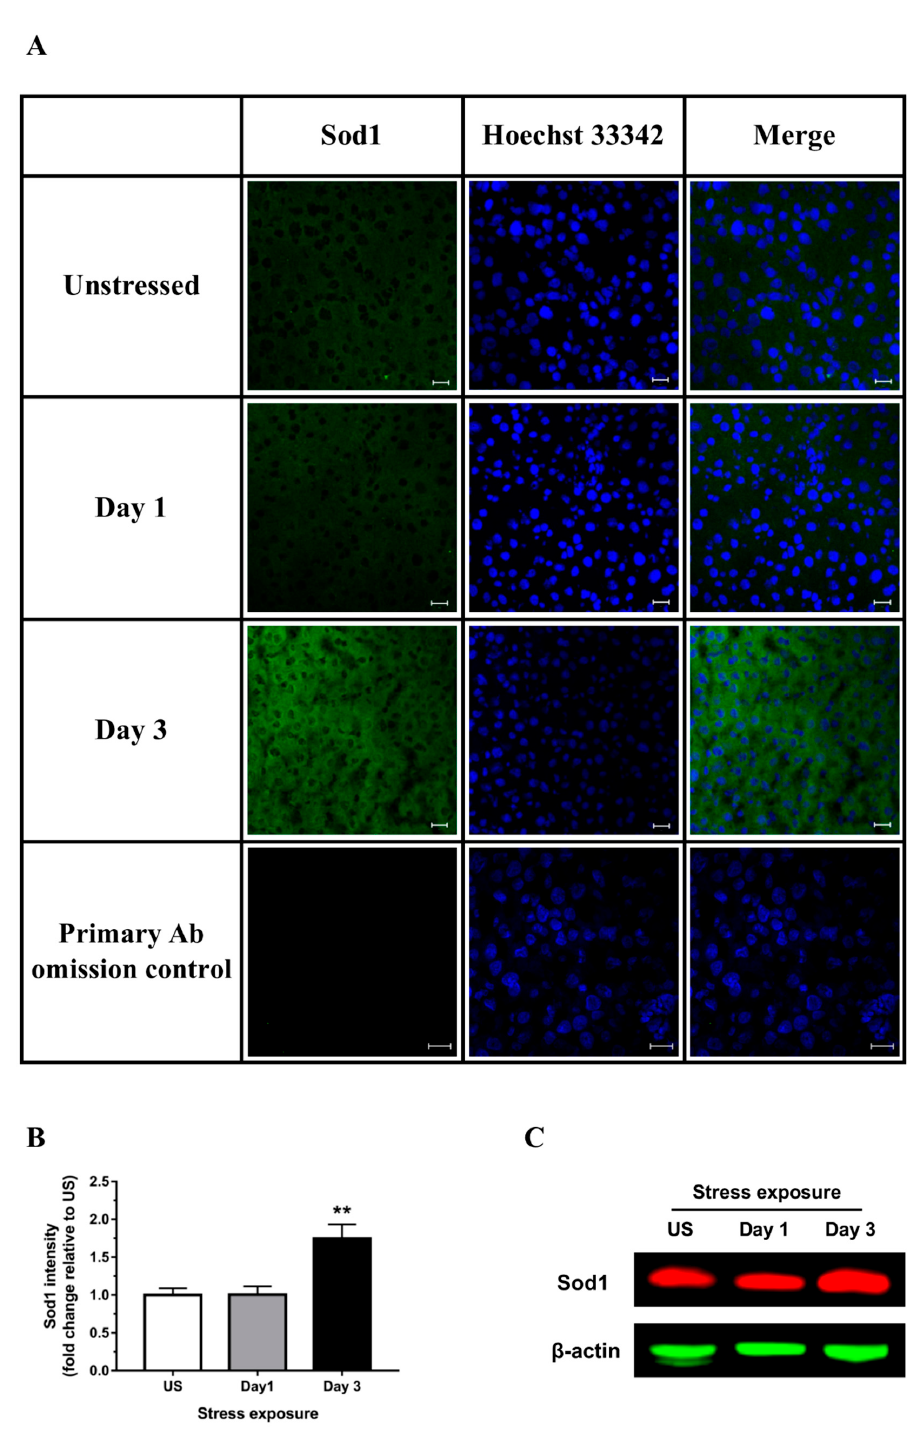
Figure 3. Representative ( A ) immunofluorescence images (scale bar = 20 µm), ( B ) corresponding image quantification (n = 3), and ( C ) Western blot of hepatic superoxide dismutase 1 (Sod1). Results in ( B ) were analyzed using one-way ANOVA with Fisher’s LSD test. Data are expressed as mean ± SEM, ** p < 0.01.